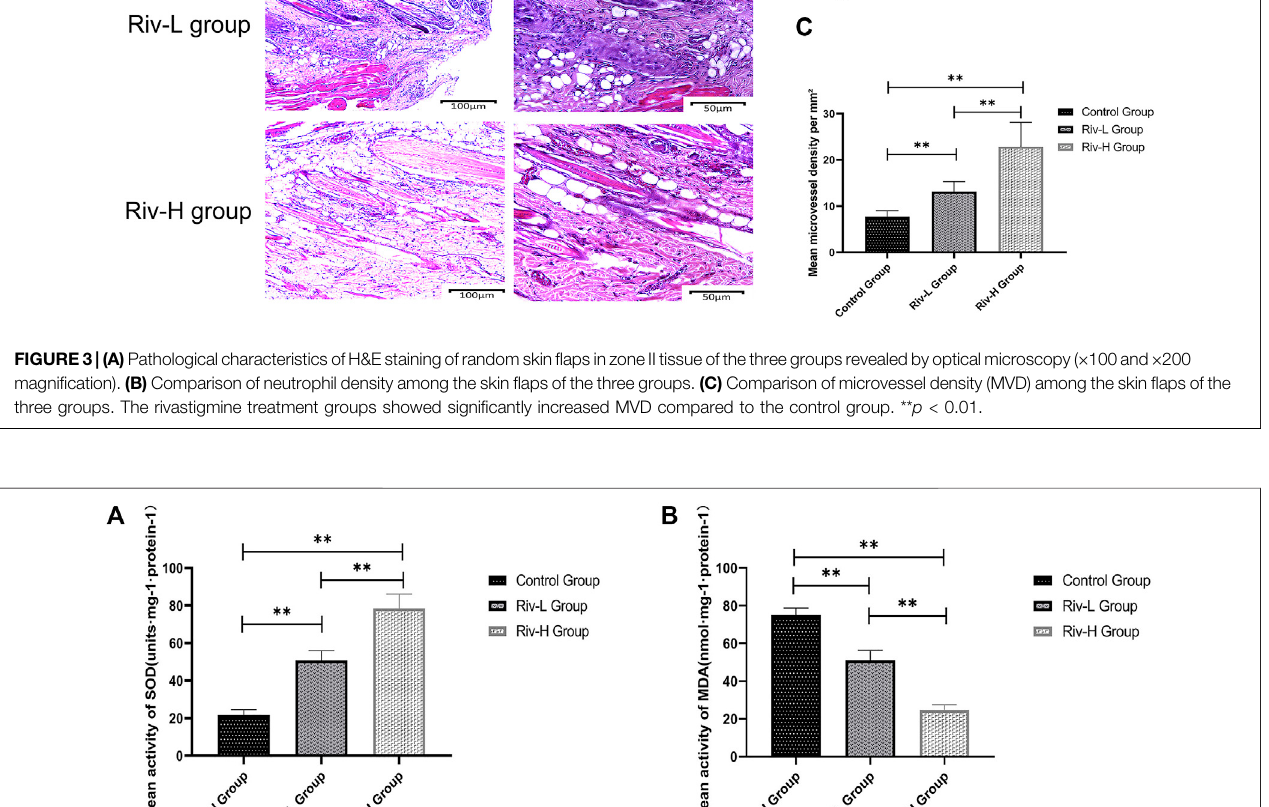
1,618.83 ± 180.28, and 2,201.67 ± 154.66 IA, respectively ( Figure 5B ).